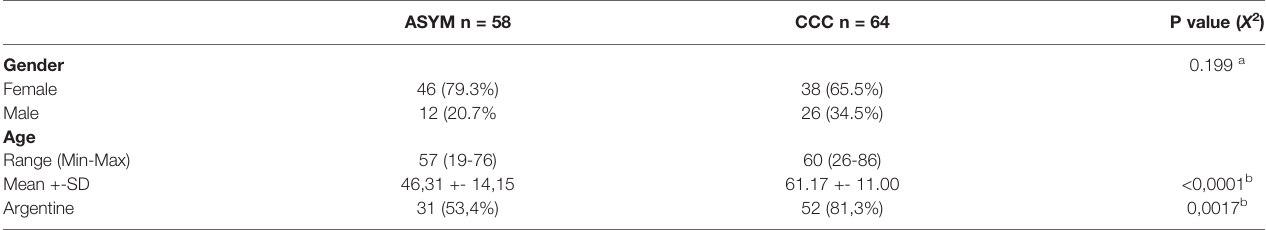
TABLE 1 | Demographic Parameters of Chronic Chagas Cardiomyopathy (CCC) Patients and Control Group